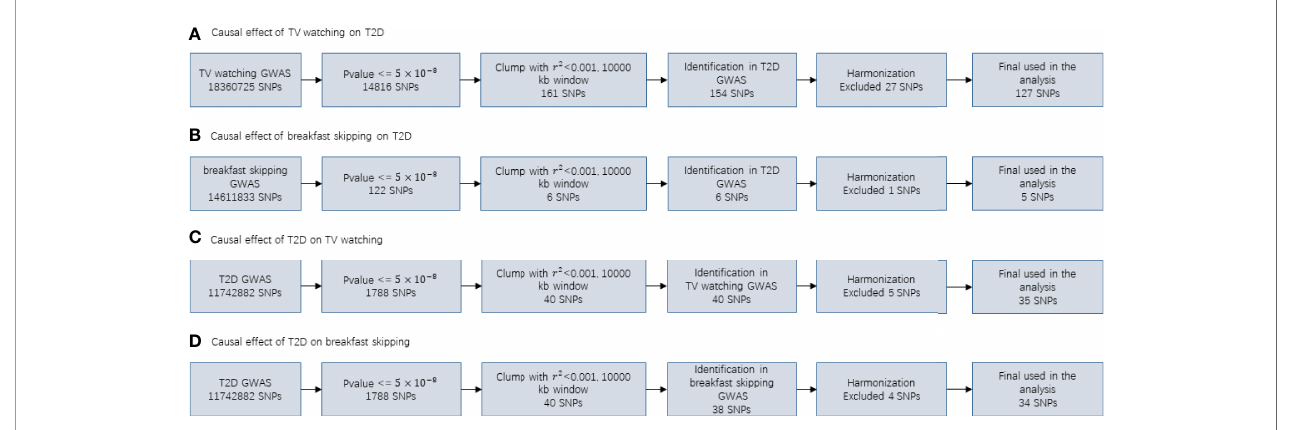
FIGURE 3 | Flowcharts visualizing the process for instrument de fi nition, extraction and harmonization for the two-sample MR analyses conducted in the present study.